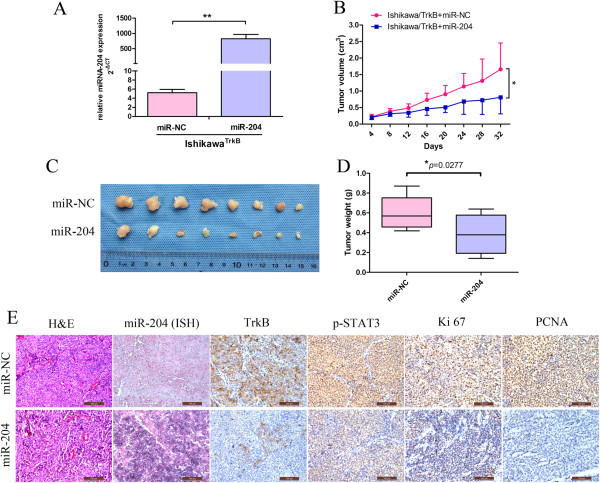
MiR-204-5p inhibits the growth of mouse xenografts bearing human endometrial carcinoma cells. (A) IshikawaTrkB cells were transfected with lentiviruses encoding miR-204 or its scrambled control (NC). MiR-204 was detected by TaqMan PCR and normalized against U6B. Data are expressed as mean ± SD of at least three independent experiments. ** P < 0.01. (B) Tumor growth curve in nude mice bearing IshikawaTrkB cells transfected with lentiviruses encoding miR-204 or its scrambled control. Data are expressed as mean ± SD of 8 mice. * P < 0.05. (C) Photograph of tumor xenografts. (D) Tumor weights are expressed as mean ± SD of tumors from panel C. *P < 0.05. (E) Representative H&E staining histopathology of miR-204 NC and miR-204 tumor tissues in mice (left panels). MiR-204 expression was detected by in situ hybridization (second panels), and TrkB, p-STAT3, Ki 67 and PCNA expression was detected by immunohistochemistry (right panels) (magnification, 200×). Results are representative of three independent experiments.